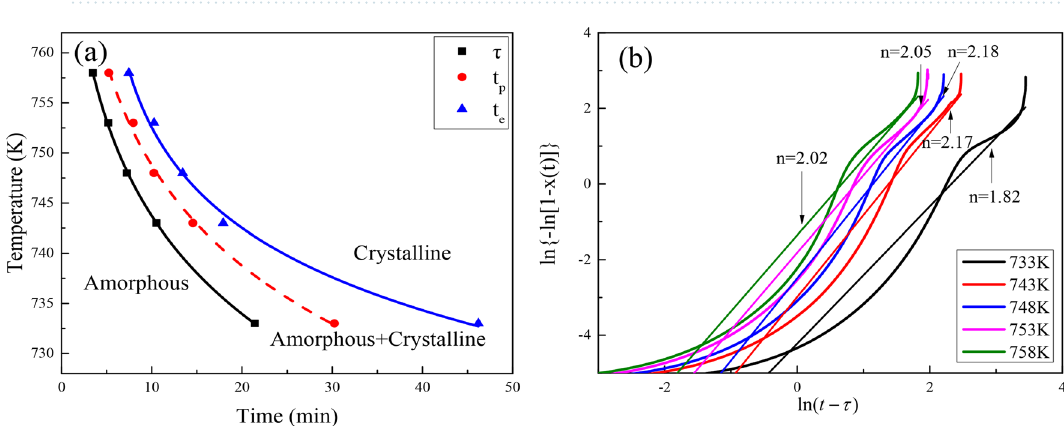
Figure 3. ( a ) Isothermal TTT curves and ( b ) JMA curves at different